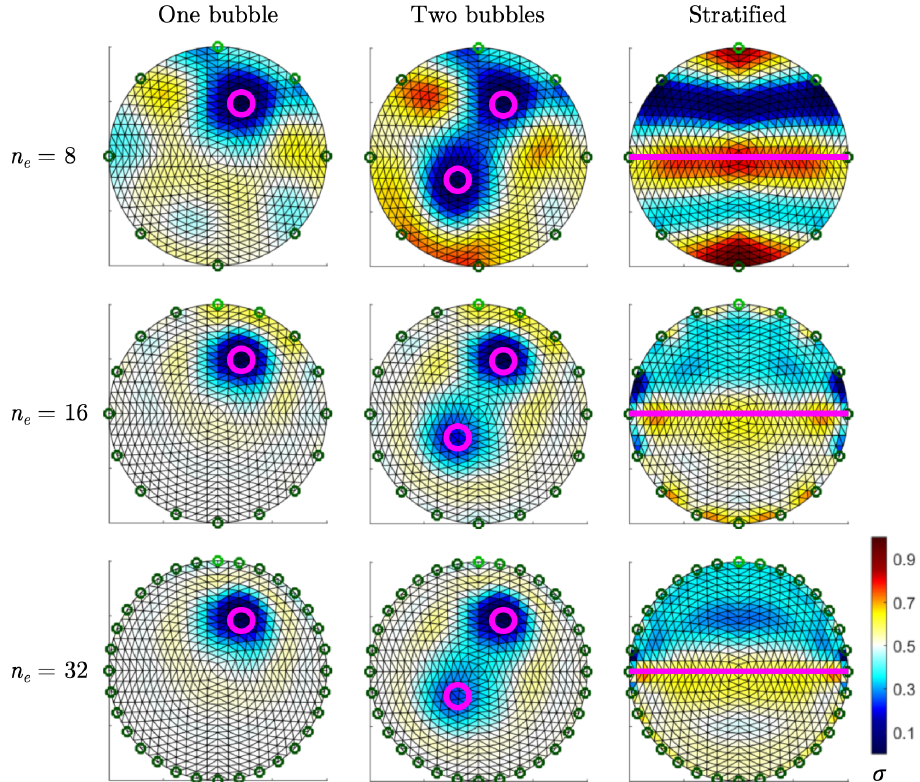
Figure 2. Image reconstruction using linear back projection from simulated data of bubbles in liquid for EIT detectors containing 8, 16, and 32 electrodes, represented with the green circles. On the left, one bubble of diameter 0.1 D , with D being the diameter of the pipe. In the middle, two bubbles of the same diameter. On the right, stratified flow. The gas–liquid interface is shown with the purple